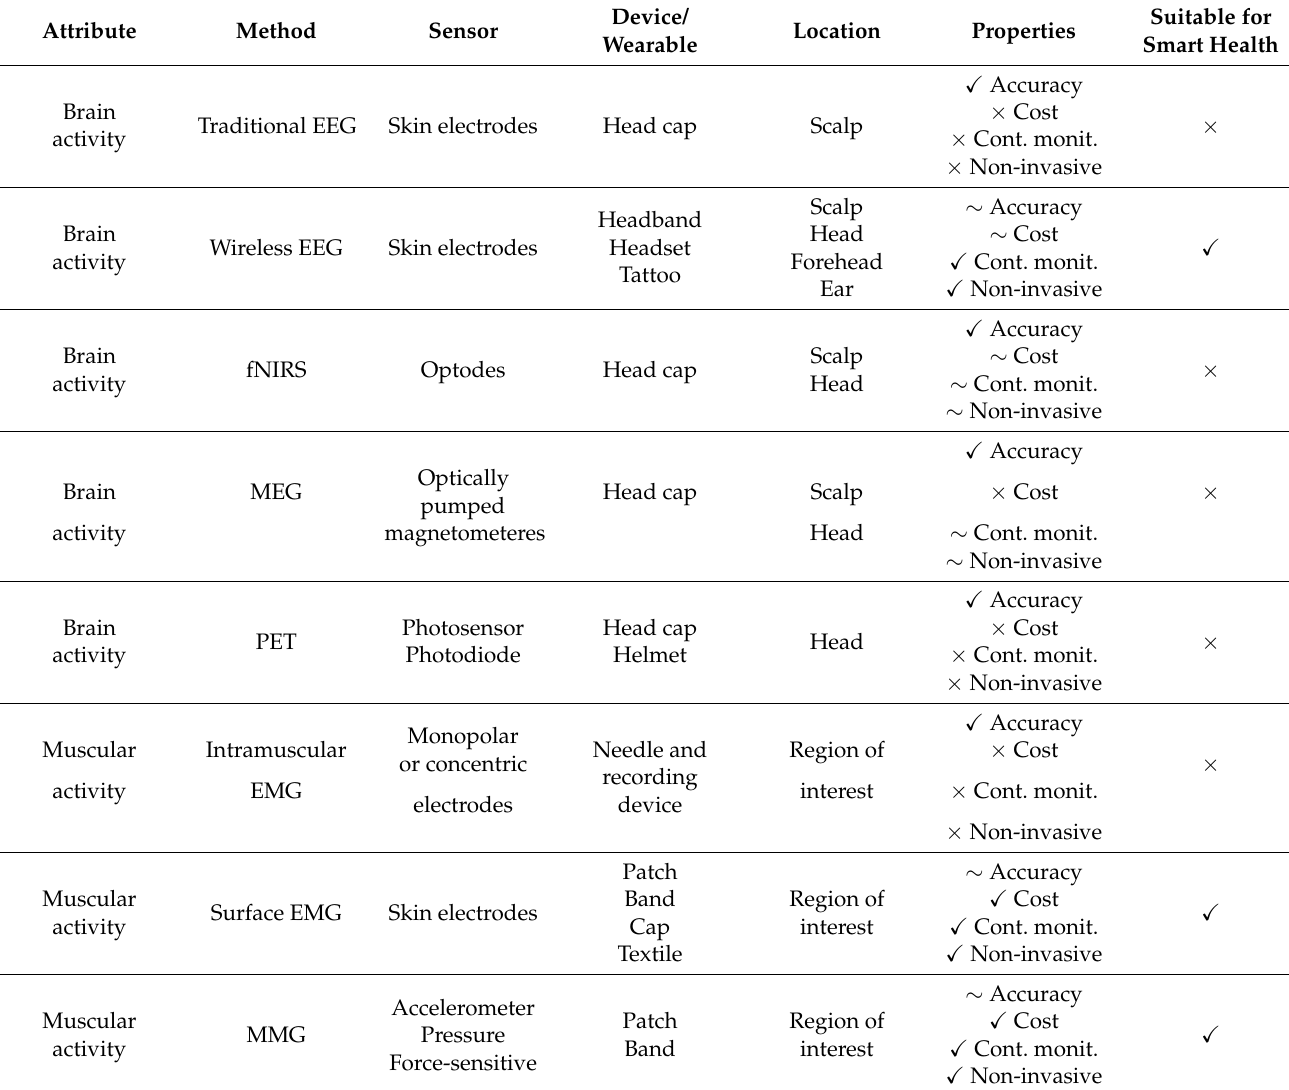
Table 5. Characteristics of the methods for brain activity sensing and muscular activity sensing.